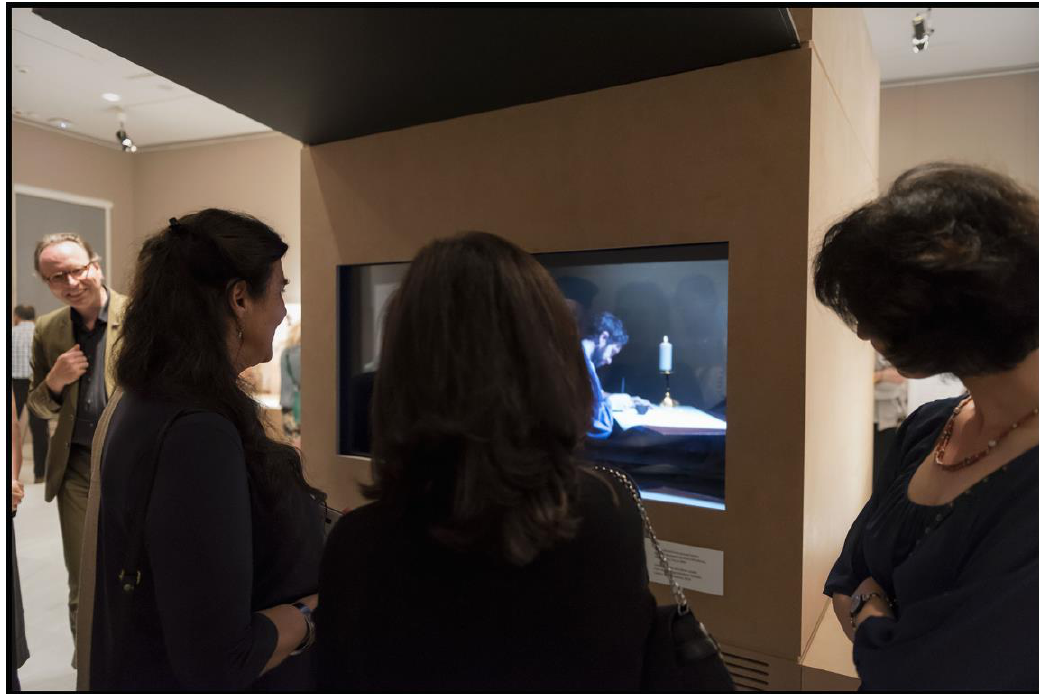
Figure 3. Big holographic showcase in Byzantine and Christian Museum of Athens. Realized by